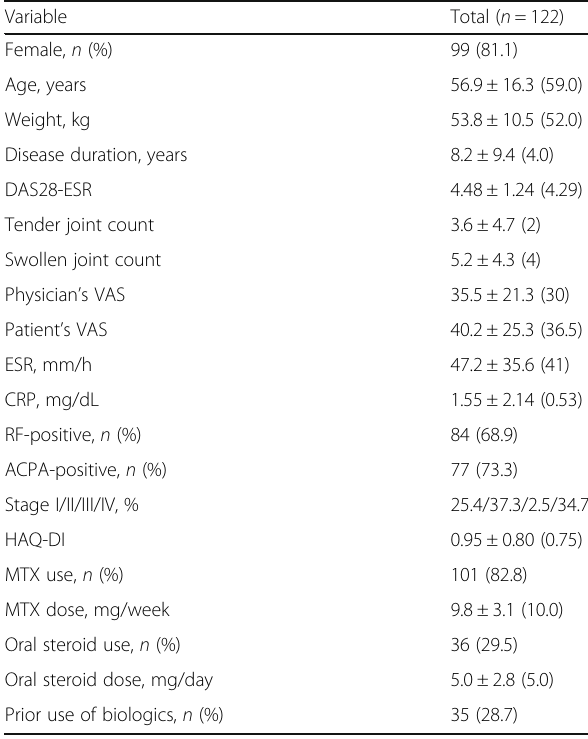
Table 1 Baseline characteristics of